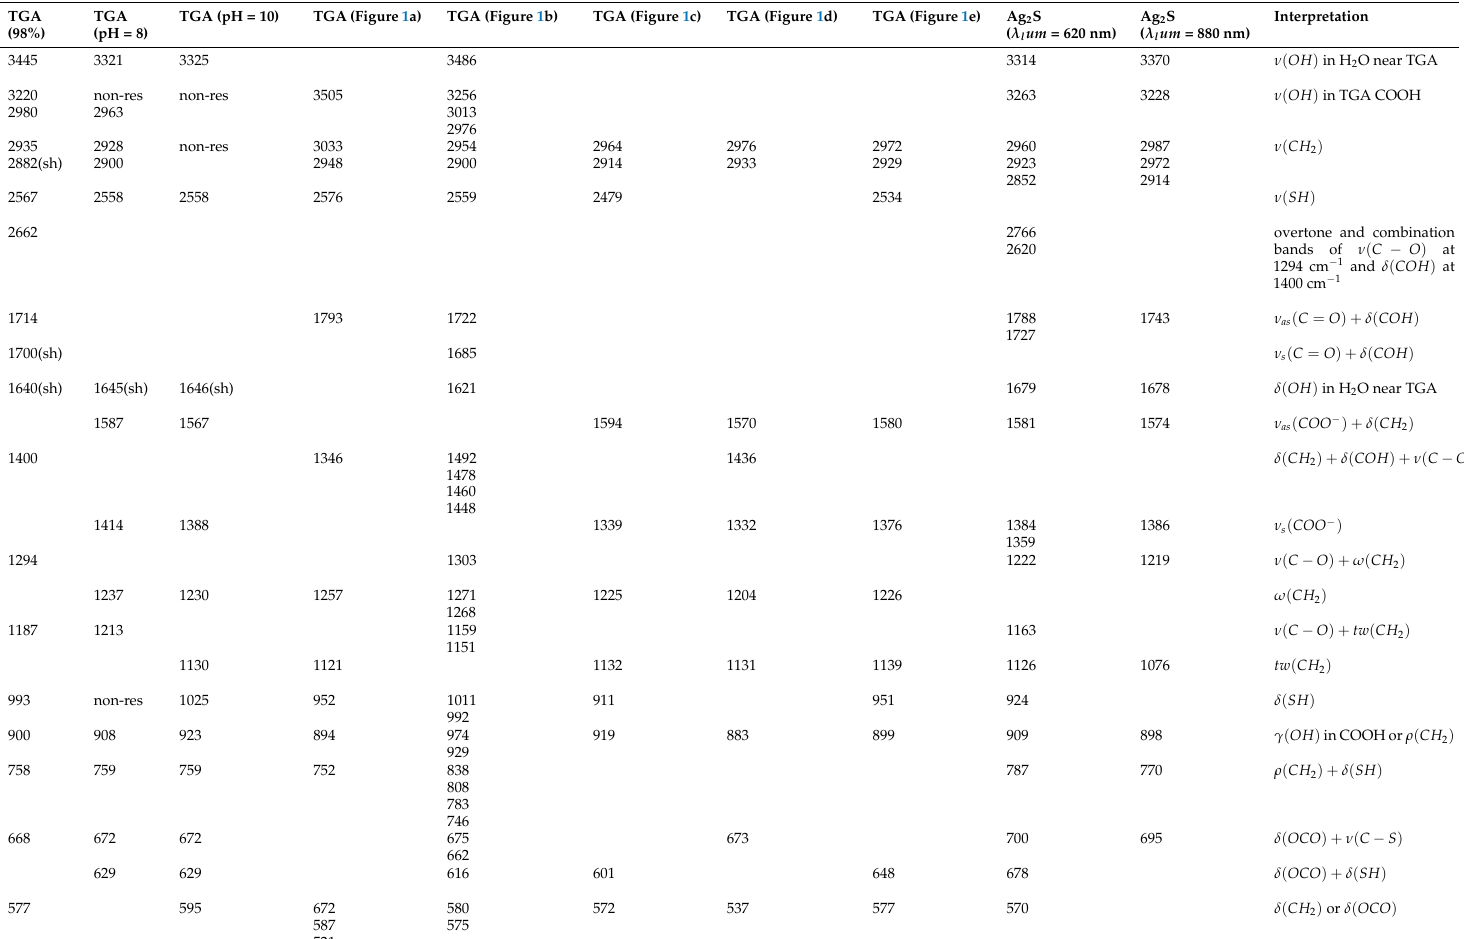
Table 1. Experimental and calculated data on characteristic modes of TGA FTIR bands in variously